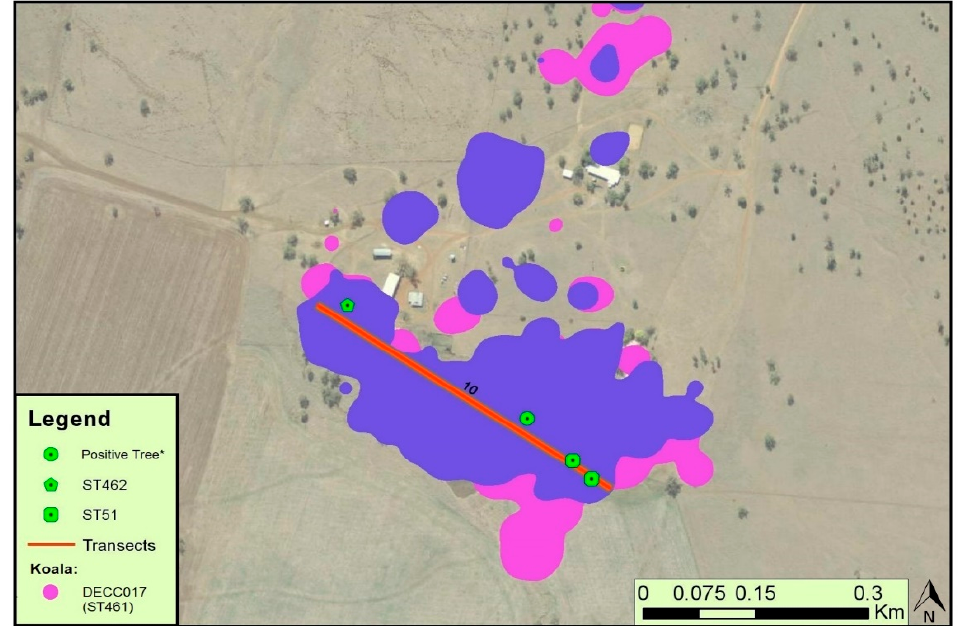
Figure 3. Map showing Transect 10 from the Dimberoy site overlaying koala home ranges with trees which were positive for C. gattii labelled, and associated sequence types provided when available. The regions highlighted in colours represent the home ranges of individual koalas. Only the koala with nasal colonisation and sequence-typed isolates is denoted in the legend. * Positive trees from which isolates were collected but no sequence types were not obtained due to sequencing issues.